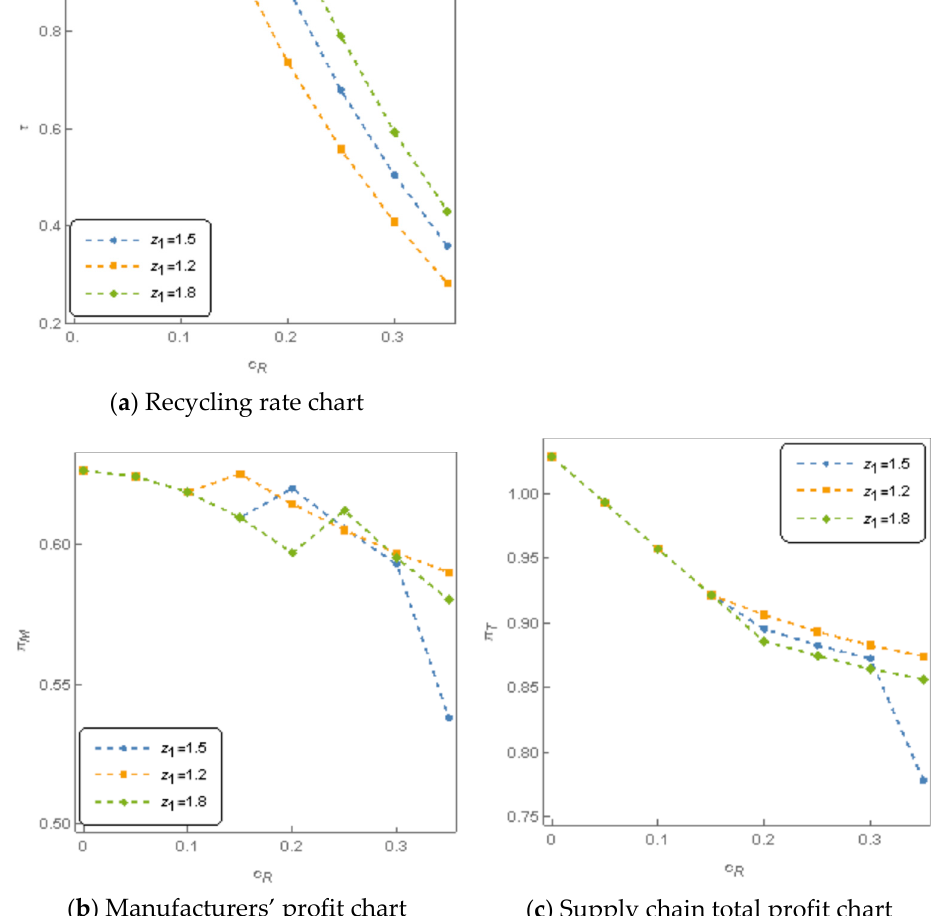
Figure 6. Influence analysis of parameter z. ( a ) Recycling rate chart; ( b ) Manufacturer’s profit chart; ( c ) Supply chain total profit chart.